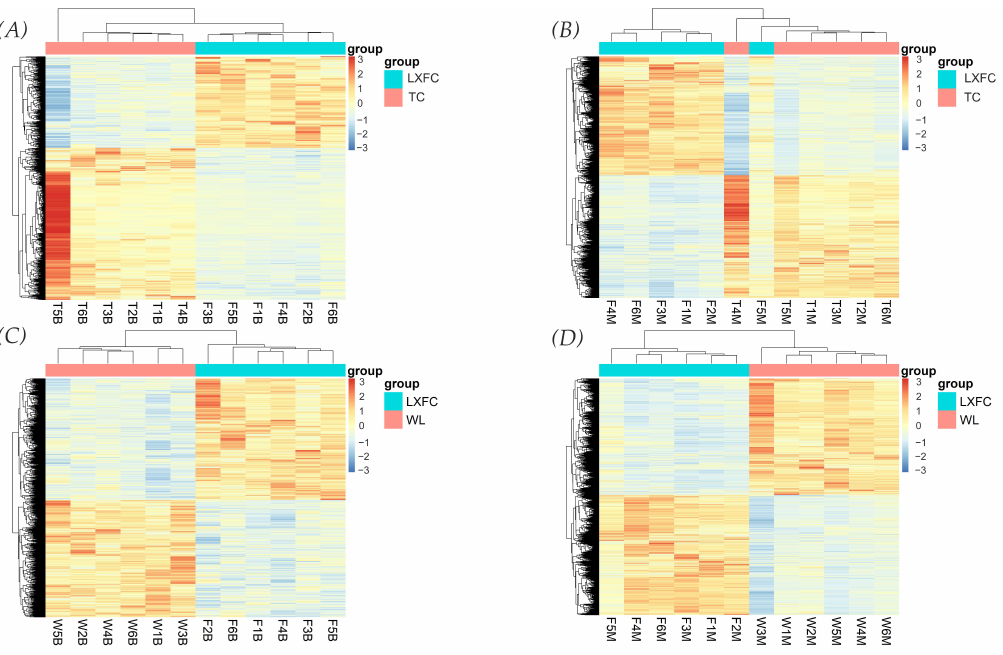
Figure 3. Heatmaps of genes differentially expressed between LXFC and TC/WL chickens in the cerebral cortex and midbrain. ( A ) DEGs between the cerebral cortex of LXFC and TC birds. ( B ) DEGs between the midbrains of LXFC and TC birds. ( C ) DEGs between the cerebral cortex of LXFC and WL chickens. ( D ) DEGs between the midbrains of LXFC and WL birds. Genes 2022, 13, x FOR PEER REVIEW